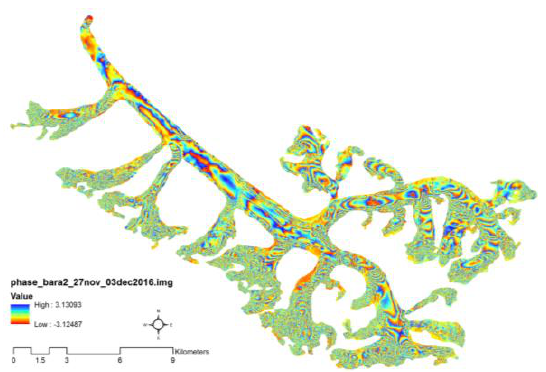
Figure 13: Phase map of Bara Shigri glacier